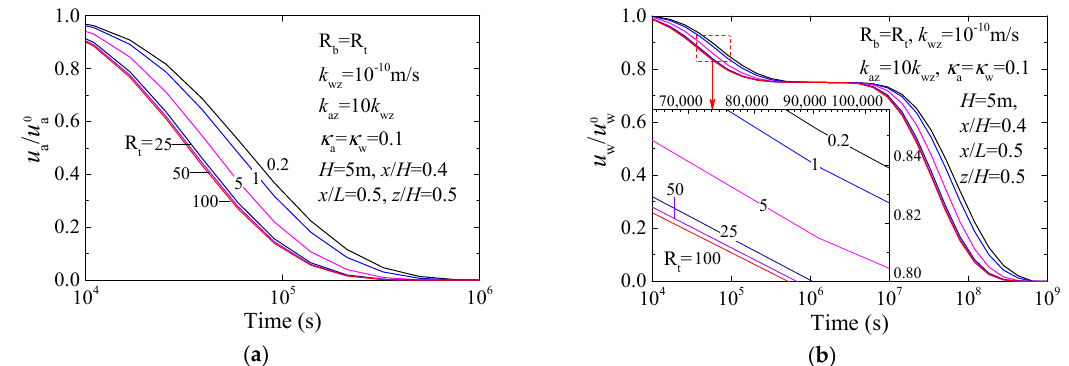
Figure 5. Variations of excess pore-pressures under symmetrical vertical impeded drainage boundary with different drainage efficiencies: ( a ) air phase and ( b ) water phase.